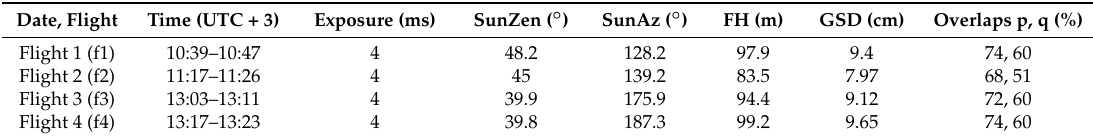
Table 2. Characteristics of the image blocks. SunZen: Sun zenith angle; SunAz: Sun azimuth angle; FH: Flying height; GSD: Ground sample distance; p, q: Forward and side overlap,